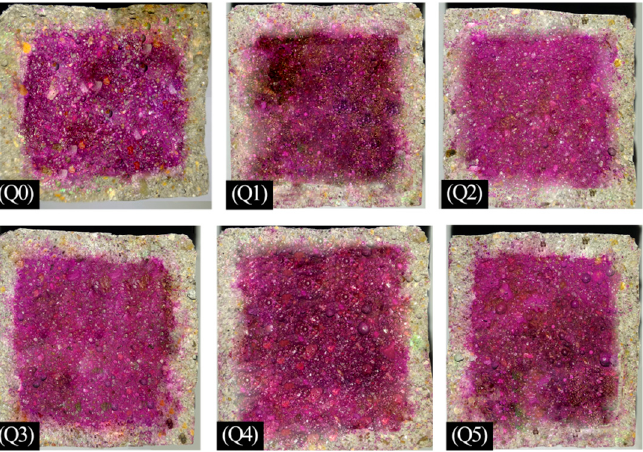
Figure 6. Image of carbonation depth under ultrasonic vibration agitation (7 d) .